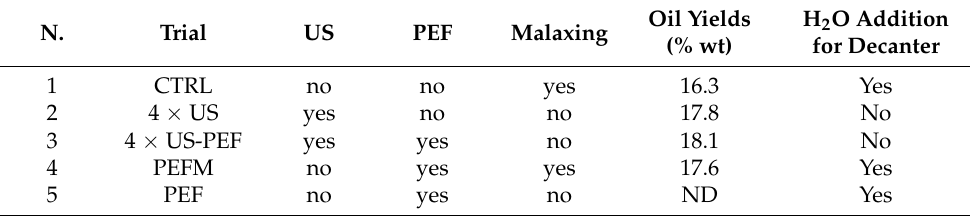
Table 2. Oil yields for the different extraction processes tested on Coratina olives.